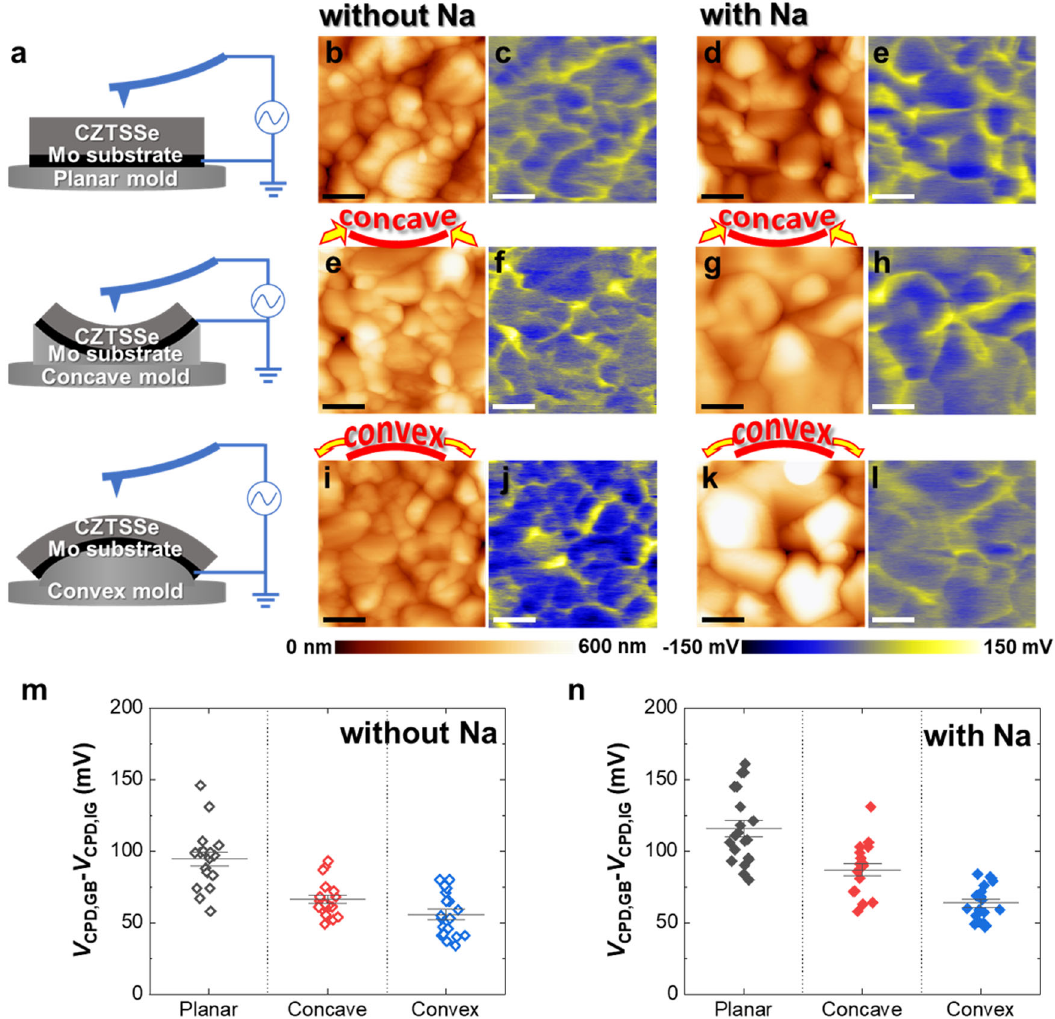
Fig. 2 Distribution of contact potential difference in various bending modes. a Diagram representing the KPFM setup in the planar and bending modes. b – l Surface topography ( b , d , e , g , i , k ) and contact potential difference ( V CPD ) map ( c , e , f , h , j , l ) of Na-undoped and doped CZTSSe absorber material in the planar state and the concave and convex bending modes with a bending radius of 20.47 mm. (scale bar: 1 μ m) m , n Distribution of V CPD difference between the intra-grain (IG) regions and grain boundaries (GBs) of Na-undoped ( m ) and doped ( n ) CZTSSe absorber material in the planar state and the concave and convex bending states. The CZTSSe absorber doped with Na displayed greater carrier separation at the GBs than the CZTSSe absorber without